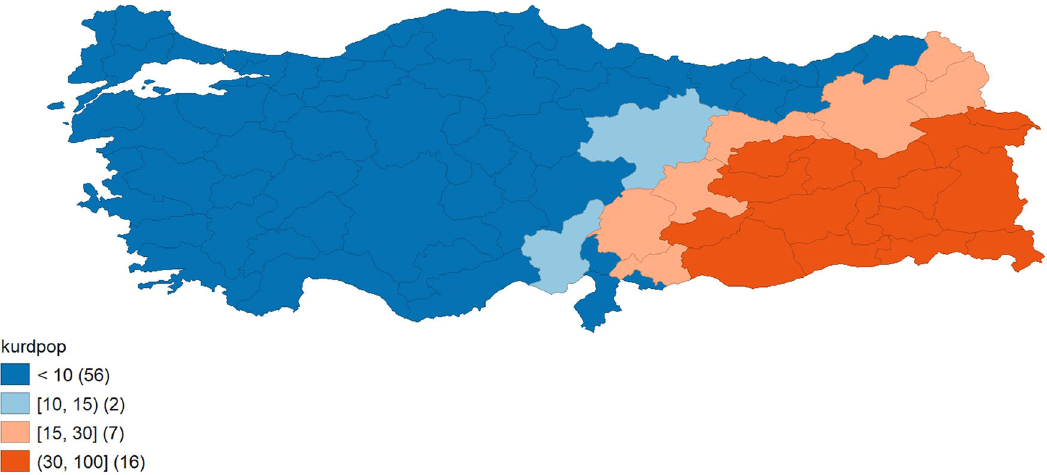
Fig. 3 The percentages of the Kurdish population. Polygon-to-Polygon spatial interpolation of Mutlu ’ s (1996) fi gures from 67 provinces to the current 81 provinces. For more information see https://desktop.arcgis.com/en/arcmap/latest/extensions/geostatistical-analyst/using-areal-interpolation-to- In Fig. 2, orange colors show positive deviations while blue colors show a negative deviation from the mean. According to the maps, the deviations above the mean for attendance of Qur ’ an courses are mostly clustered among the inner parts of Turkey and are very stable over time. It is clear from the map that only the south-eastern parts of Turkey are converting from negative to positive deviations in terms of attendance to the Qur ’ an Courses.